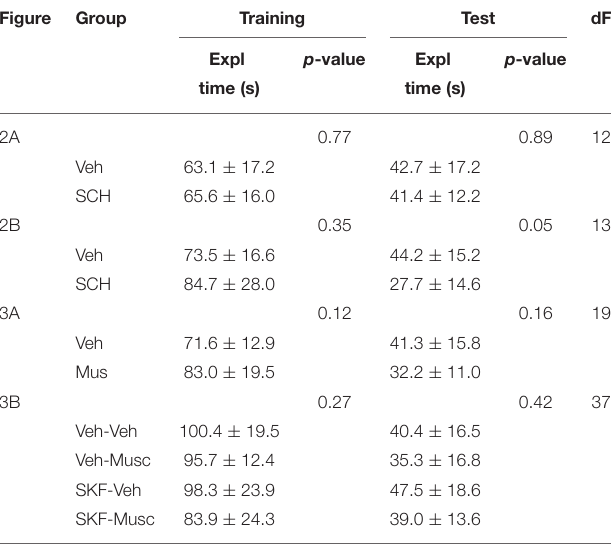
TABLE 1 | Total training and test sessions’ exploration times for each manipulation. Figure Group Training